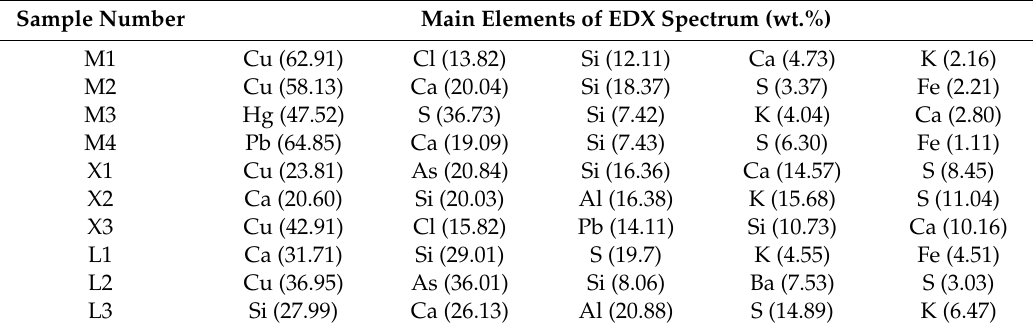
Table 3. Elemental composition of the